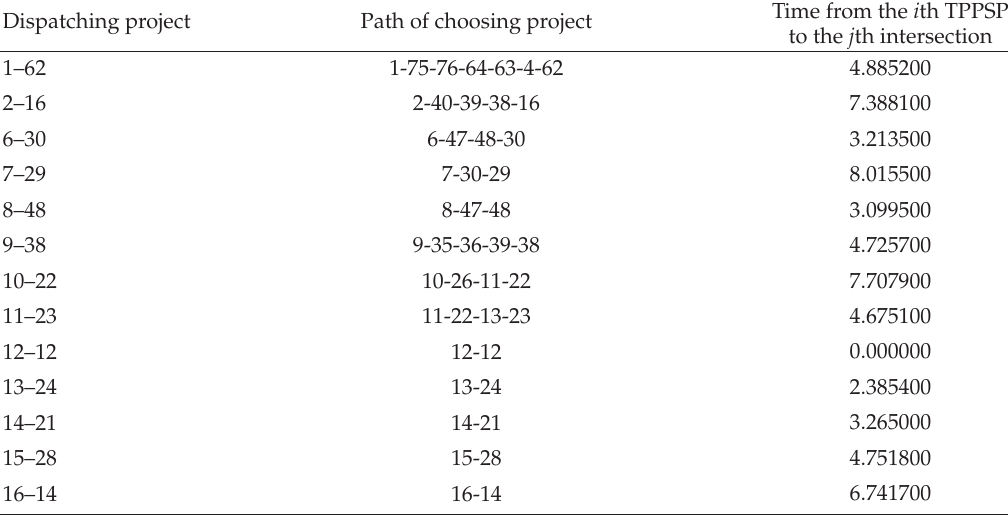
Table 4: The optimal dispatch project of TPPSP with T pq (cid:8)